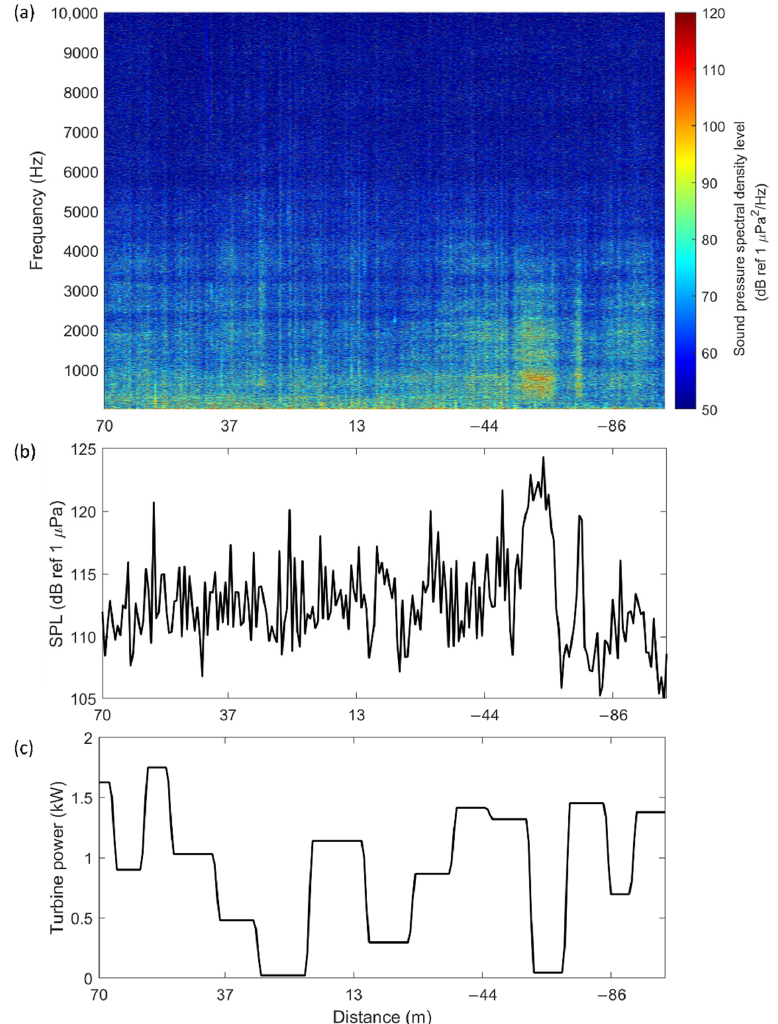
Figure 5. Examples of the sound pressure spectral level ( a ) and the sound pressure level ( b ) as a function of distance between the drifting hydrophone and the turbine axis. The horizontal axis denotes measurements from +70 m upstream of the energy converter to the minimum distance of 12 m, and then to − 93 m downstream of the turbine. Data are from the fifth drift on 23 July 2021. No significant increase in sound pressure level was observed as the hydrophone approached the turbine, and the turbine power output remained relatively stable ( c ). A non-recurring increase in sound pressure and spectral levels is observed from − 50 m to − 60 m, possibly attributed to a distant passing vessel- or bridge-related noise.